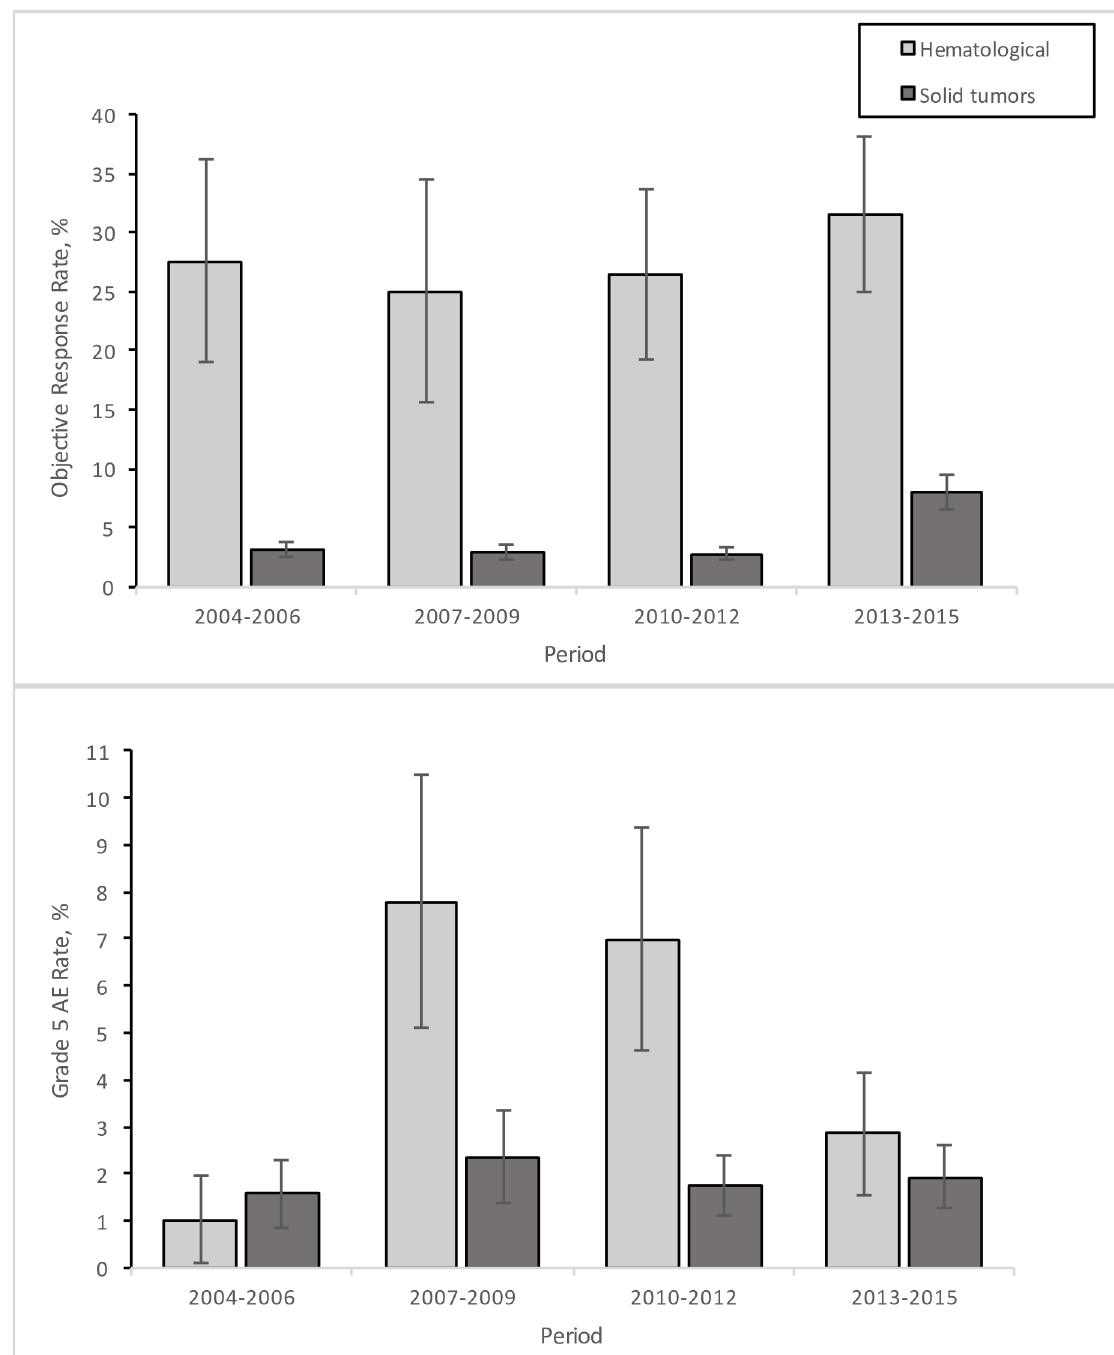
Fig 1. Time trends in response and treatment-related toxicity. Response and fatal (grade 5) adverse event (AE) rates were calculated for categories of publication year (2004–2006, 2007–2009, 2010–2012, and 2013–2015) to assess changes over time. Error bars indicate standard